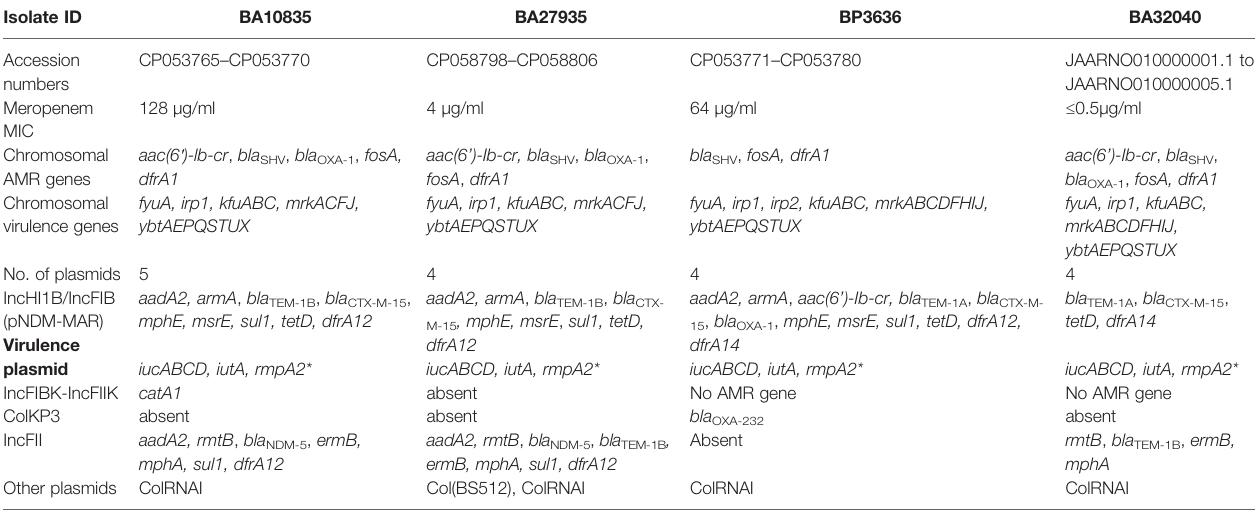
TABLE 2 | Phenotypic and genotypic characteristics obtained using hybrid genome assembly of four Indian MDR hypervirulent K. pneumoniae ST2096. Isolate ID